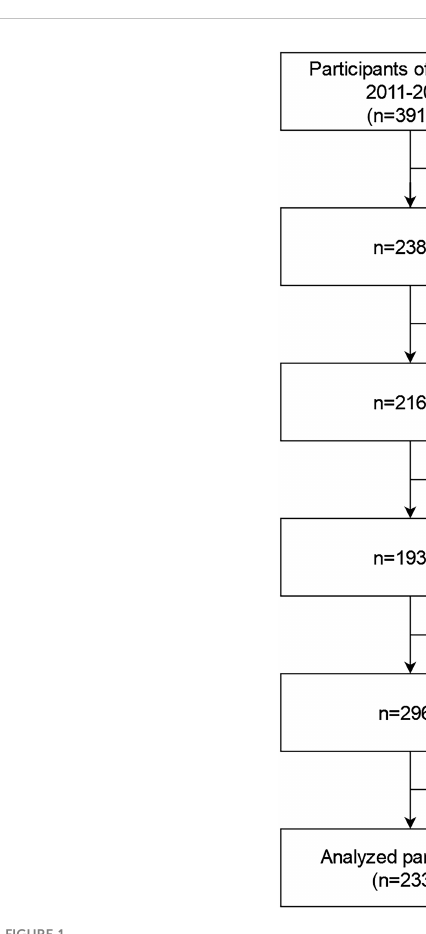
FIGURE 1 Flowchart for selecting analyzed